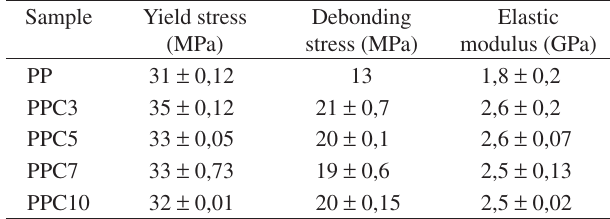
nanocomposites. 3